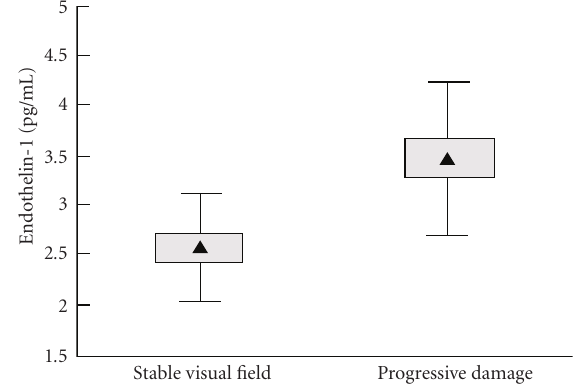
Figure 5: Plasma concentration of ET-1 in patients with glaucoma with and without visual field progression (triangle = mean; box = standard error od the mean; whiskers = standard deviation). Plasma levels of ET-1 at the end of the observation period were significantly higher in patients with progressive damage (3.47 (0.75)pg/ml; range 2.34–5.17 pg/ ml) compared with those with stable